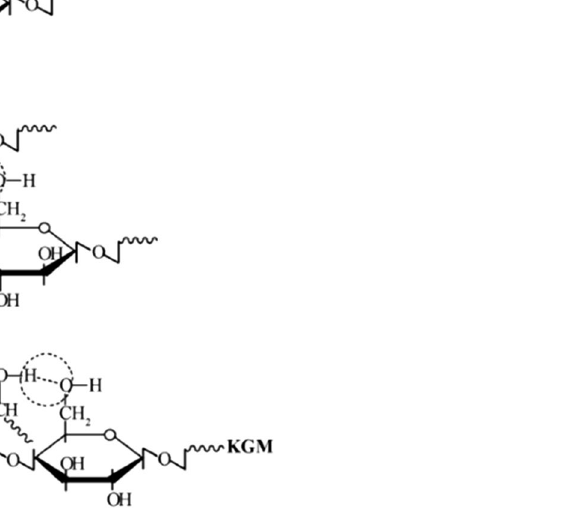
Figure 14. The interaction between KGM, CA and